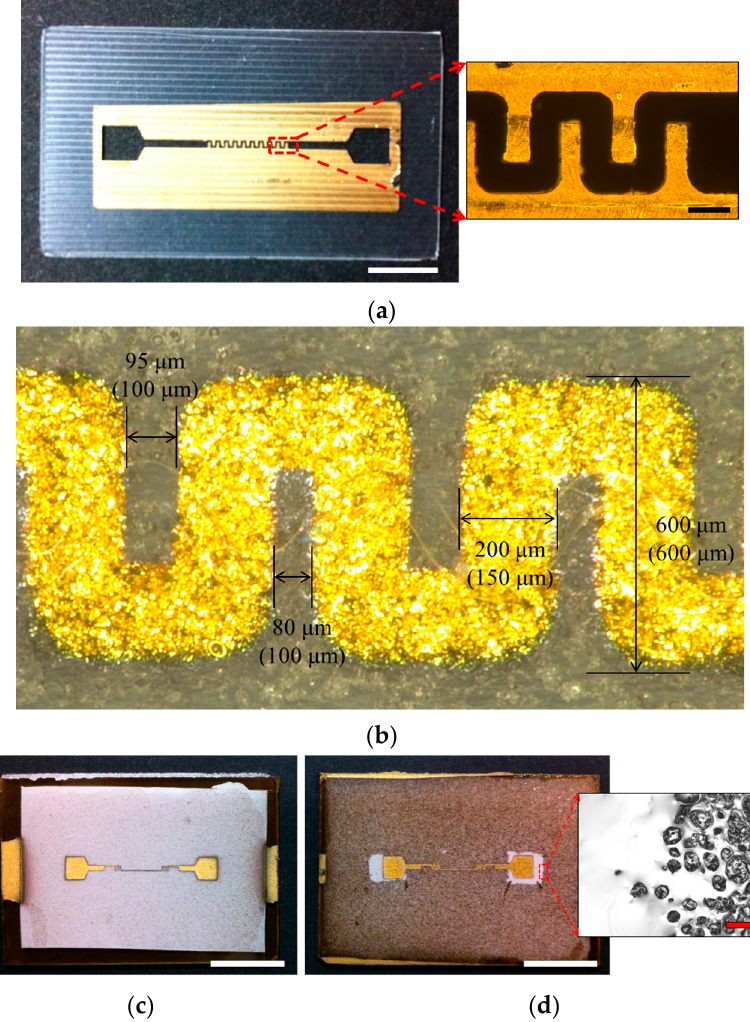
Figure 4. Photograph of the electrode: ( a ) Photograph and microscope image of an acryl mask. Each scale bar marks 5 mm (white line) and 200 μ m (black line). ( b ) Photograph of the electrode. Though